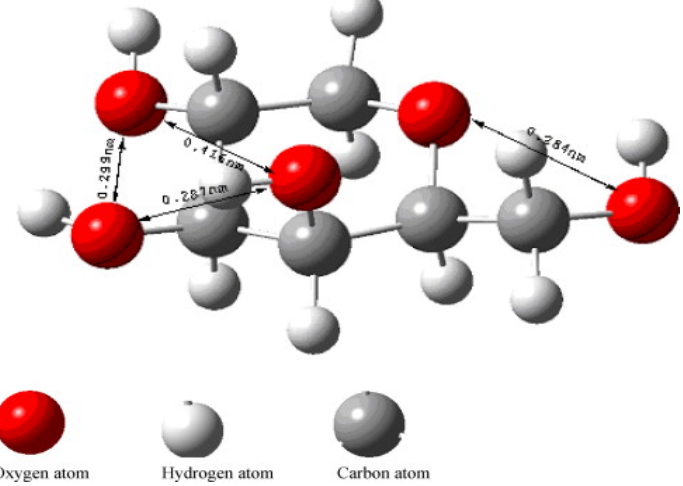
Figure 9. Stereo structure of a monomer produced the collodion membrane. The monomer binds to calcium ions for vaterite growth. This figure is adopted with permission from [57].